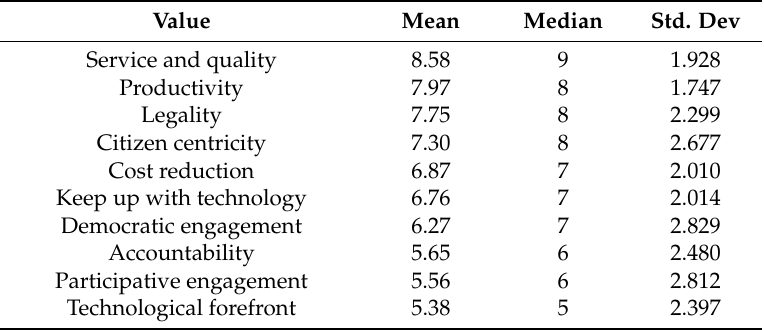
Table 6. Descriptive statistics, overall results.